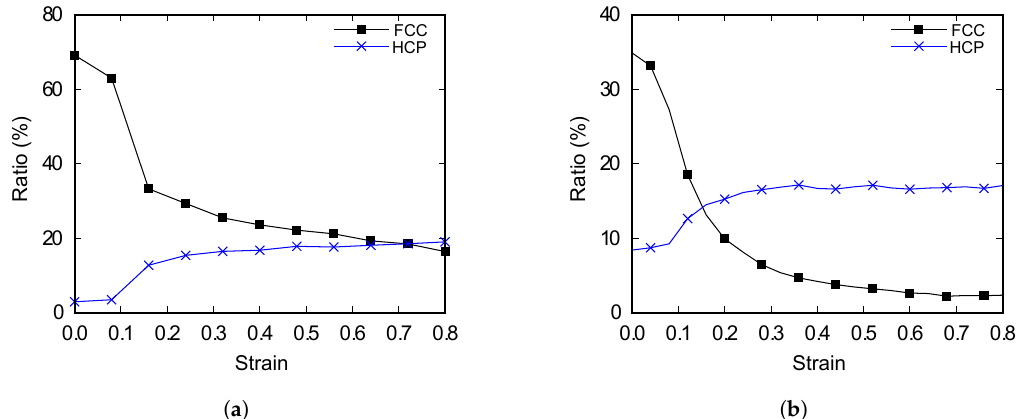
Figure 7. Lattice ratio–strain curve for copper alloy models with zinc contents of ( a ) 2.5% and ( b ) 5%,